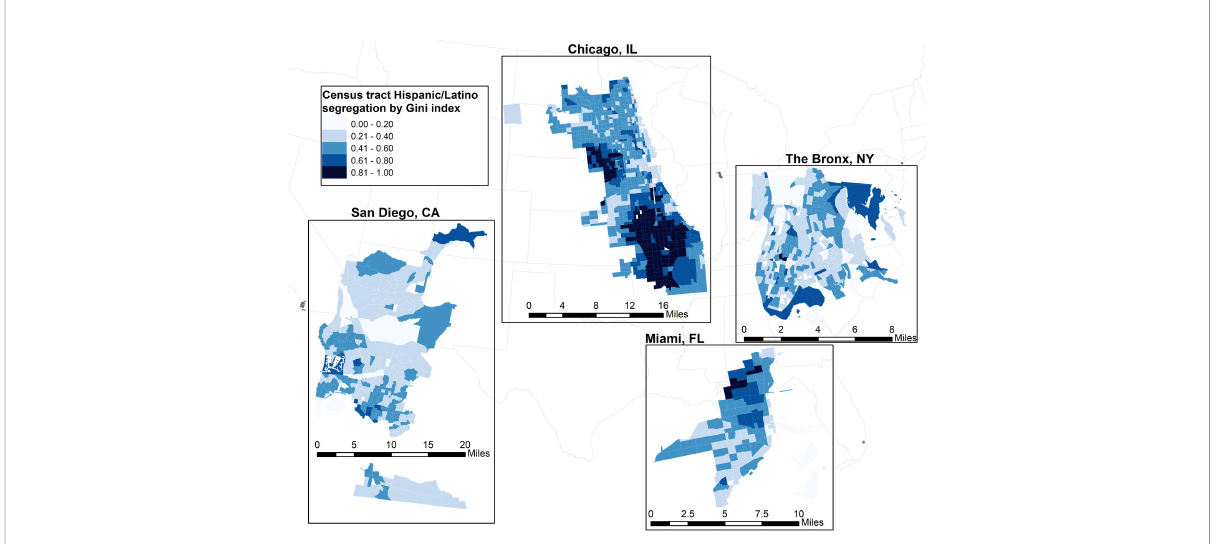
FIGURE 1 Evenness segregation of Hispanic/Latino census tracts, measured by the Gini index for each study site in the Hispanic Health Community Study/ Study of